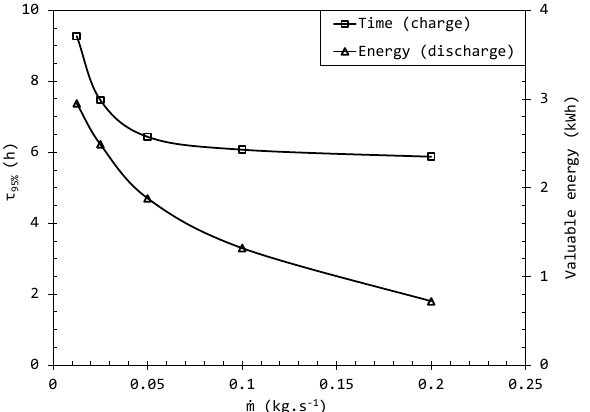
Figure 9. Charging time τ 95%, and energy stored (left axis) and storage efficiency (right axis), as functions of the inlet temperature during a charge from 43 ◦ C at 0.05 kg/s.